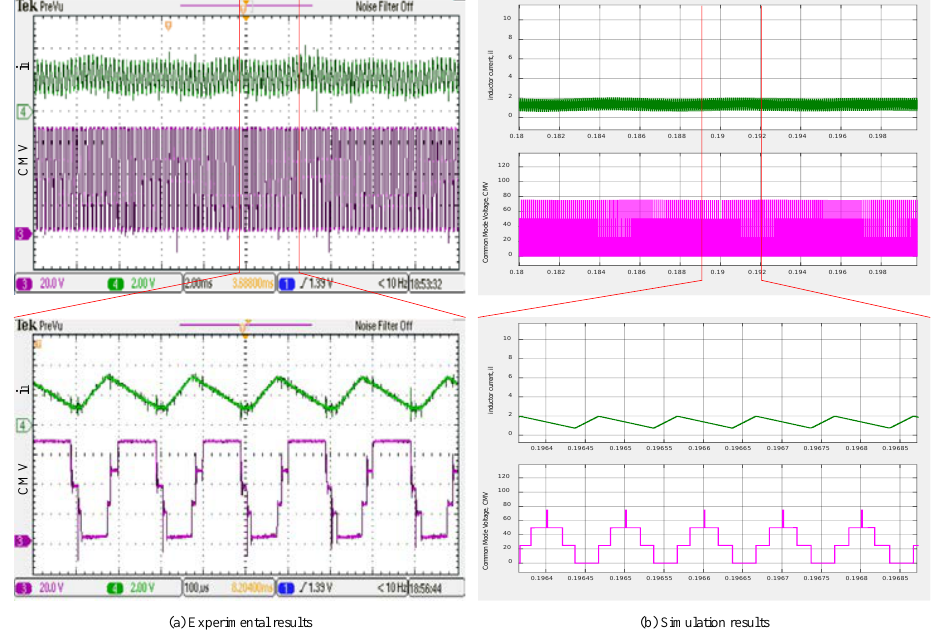
Figure 30. Inductor current and common-mode voltage.